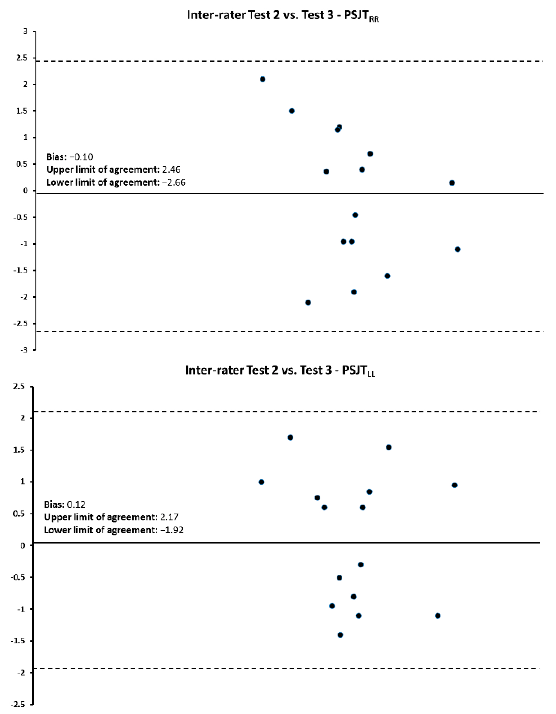
Figure 4. Bland–Altman plot for the interrater reliability between PSJT RLEG and PSJT LLEG for EGA. The difference between the two measurements per subject is plotted against the mean of the two measurements. Dotted lines represent the upper and lower limits of agreement for 95% CI.